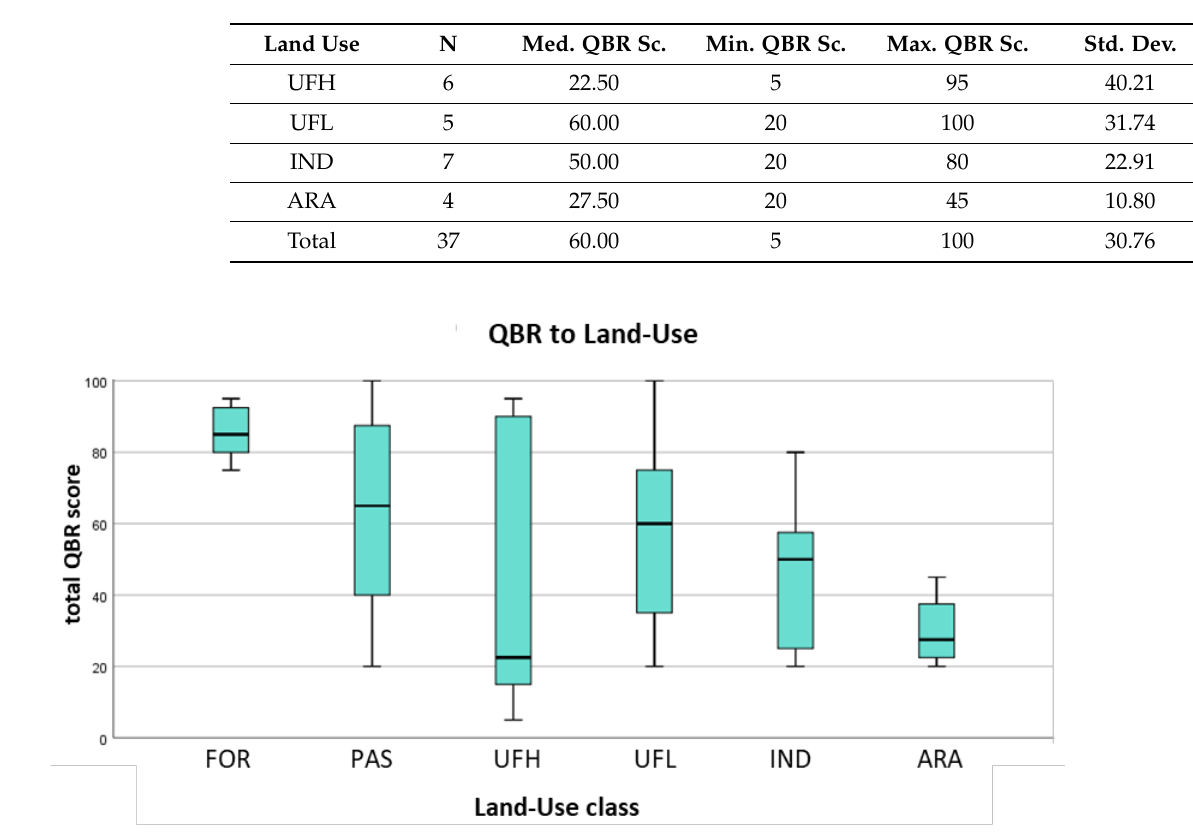
Figure 5. Boxplots of QBR scores in relation to different land-use classes.